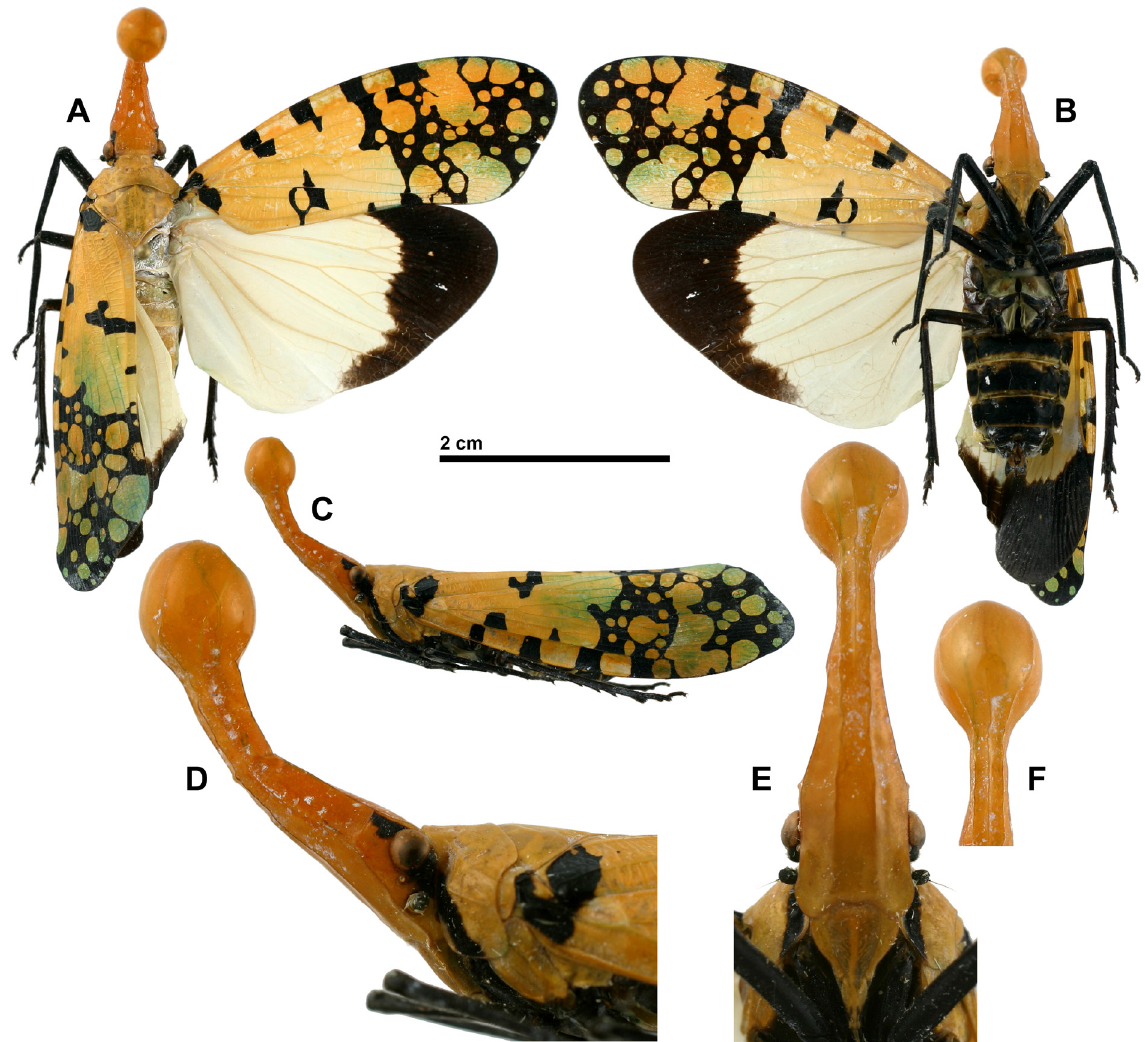
Fig. 1. Pyrops atroalbus (Distant, 1918) comb. nov., ♀, Vietnam, Quang Tri Prov., Da Krong Nature Reserve, 10 Jul. 2011 (VNMN). A . Habitus, dorsal view. B . Habitus, ventral view. C . Habitus, left lateral view. D . Head and thorax, left lateral view. E . Head, normal view of frons. F . Apex of cephalic process, frontal view. (D–F not